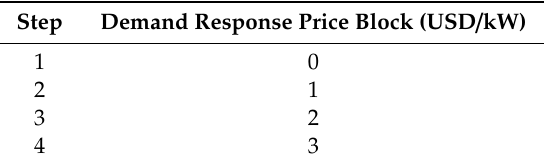
Table 3. EDRP step